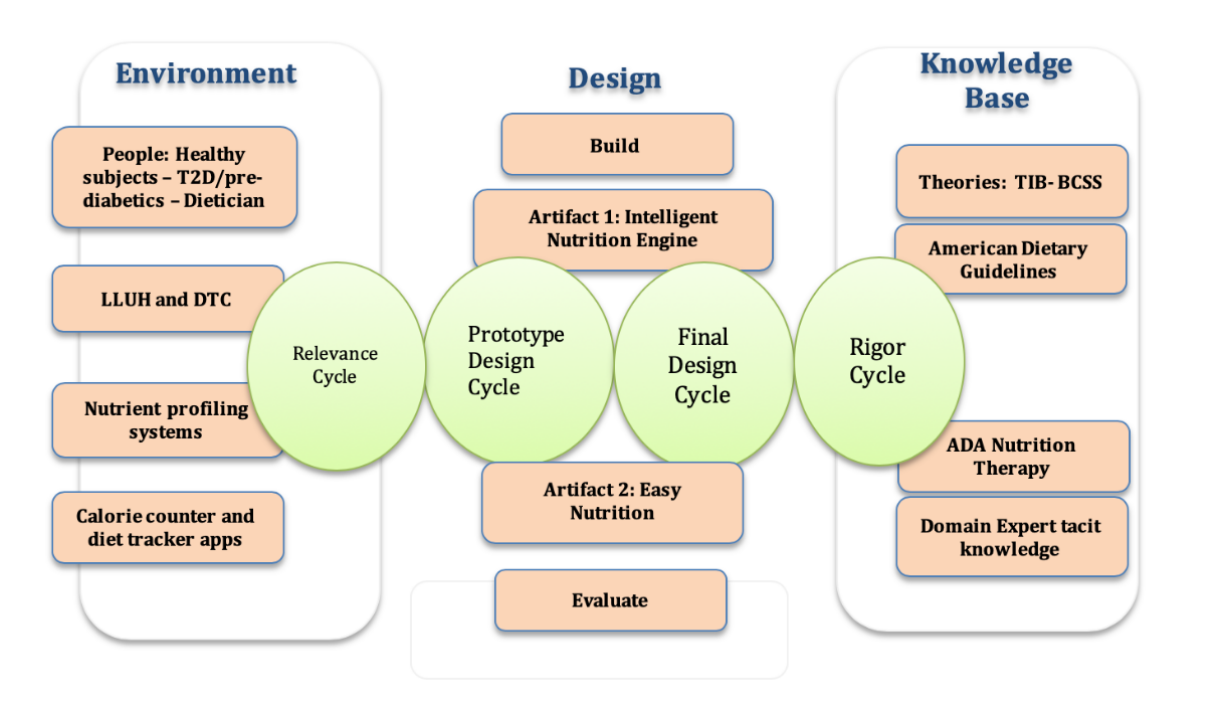
Figure 1. Design science research